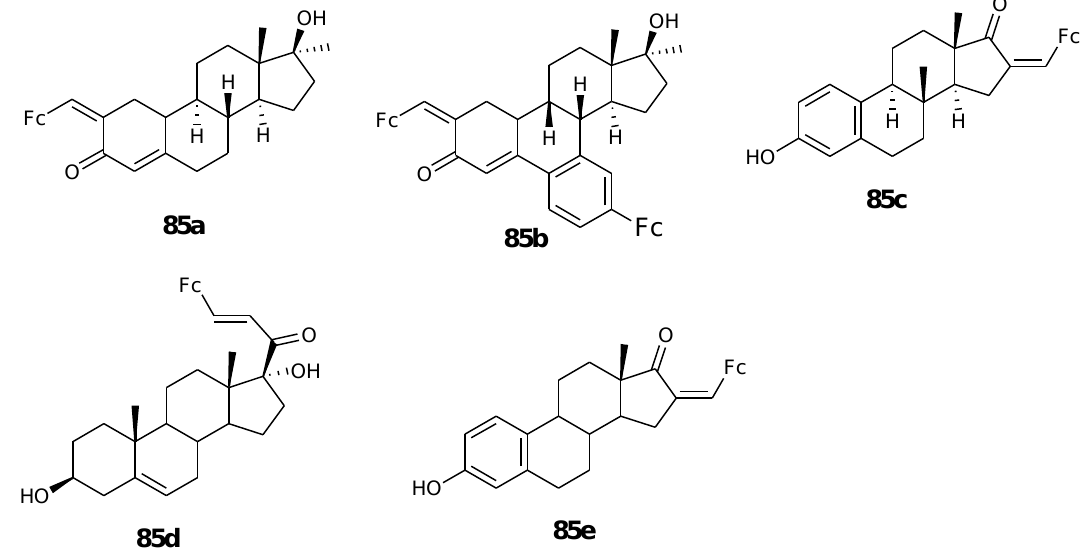
Figure 32. Chemical structures of ferrocene – steroids derivatives ( 85a – e ).